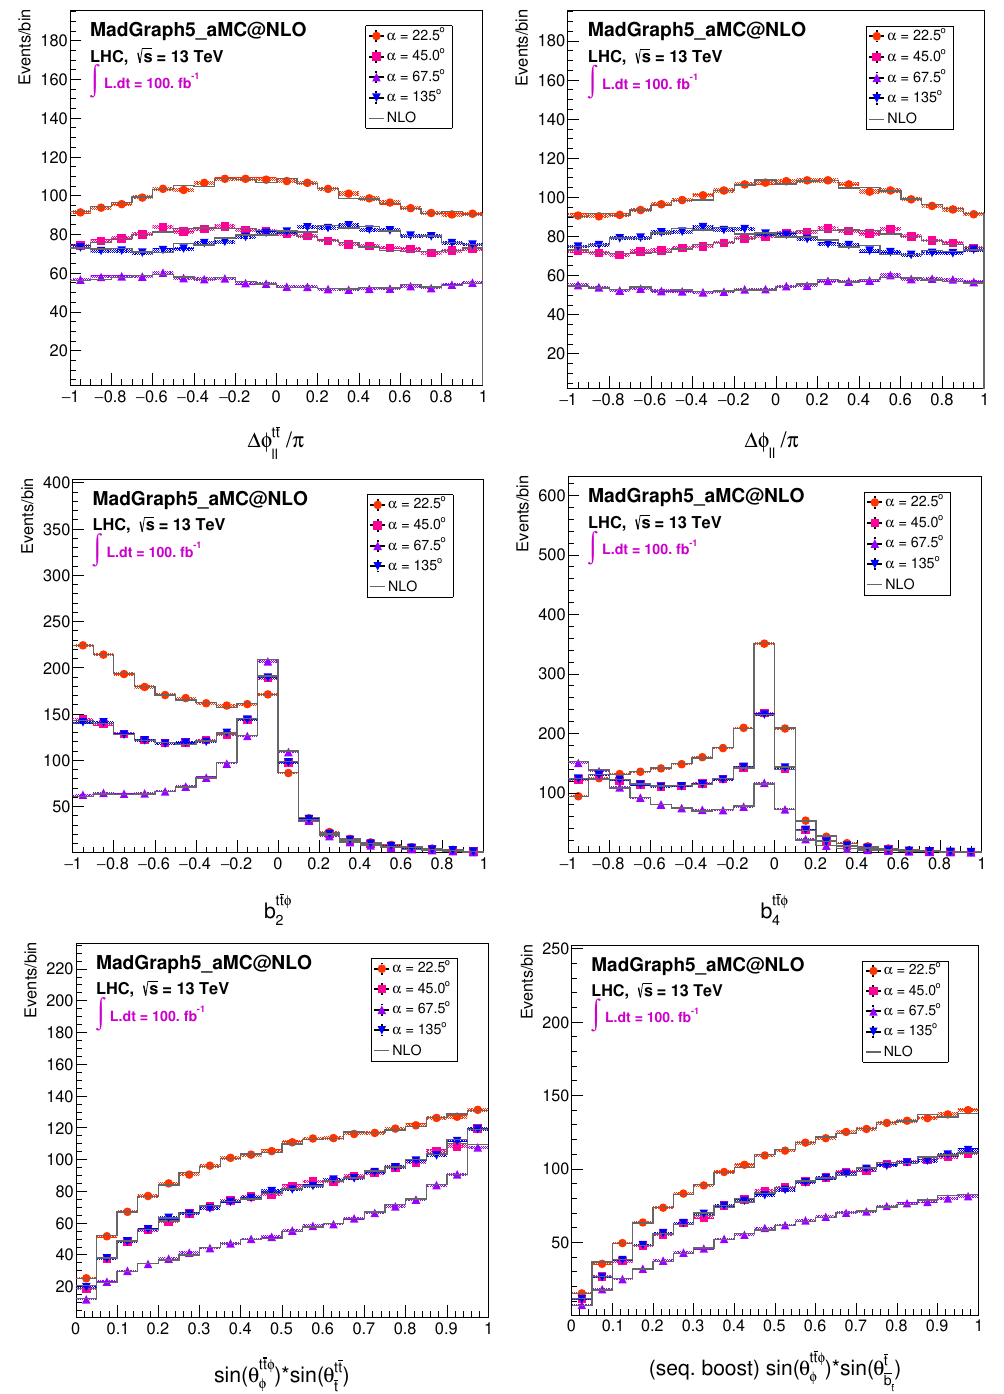
Figure 2 . The CP observables reconstructed with the pure CP-even and pure CP-odd signals together with the interference terms at parton level with shower effects (with no cuts applied), for different mixing angles ( α = 22 . 5 o , 45 . 0 o , 67 . 5 o and 135 o ), are shown against the corresponding NLO generations. Good agreement between the observables when reconstructed with the interference terms and the parton level distributions is observed.